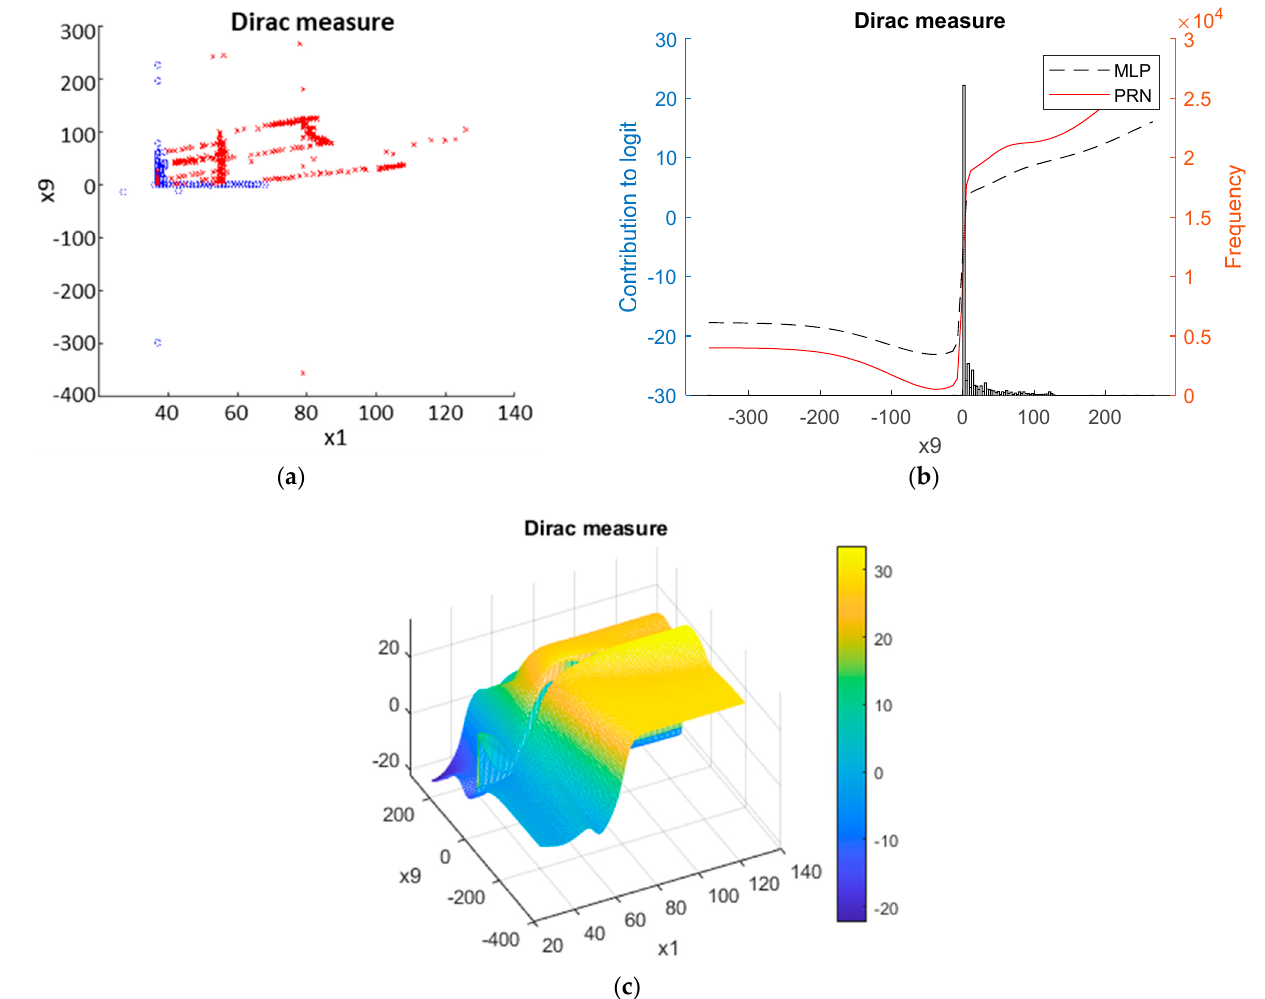
Figure 10. Nomogram of the PRN–Lasso model obtained for the Statlog Shuttle data set using the Dirac measure with a training/test split of n = 43,500 and 14,500, respectively: ( a ) Shows the raw data for the two variables selected, which corresponds well with two partial responses in the final model, namely: ( b ) shows the main effect involving x 9 ; and ( c ) plots the two-way interaction between the two variables in the model, x 1 and x 9 .